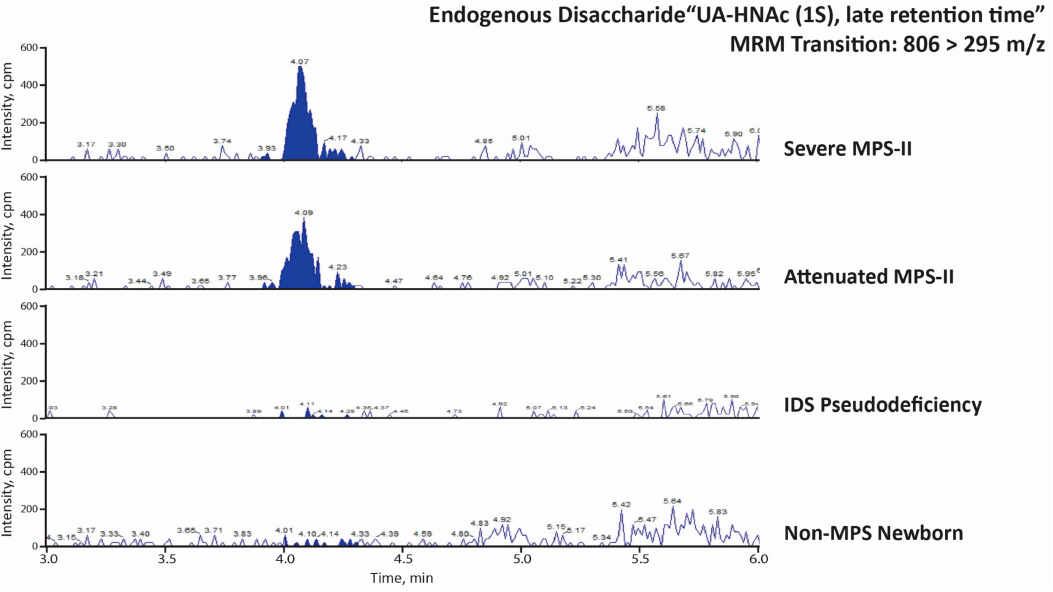
Figure 5. LC-MS/MS traces (MRM signal response versus time) for the PMP-derivatized endogenous disaccharide marker UA-HNAc (1S) late retention time (transition: 806 > 295 m / z ), using newborn DBS from indicated